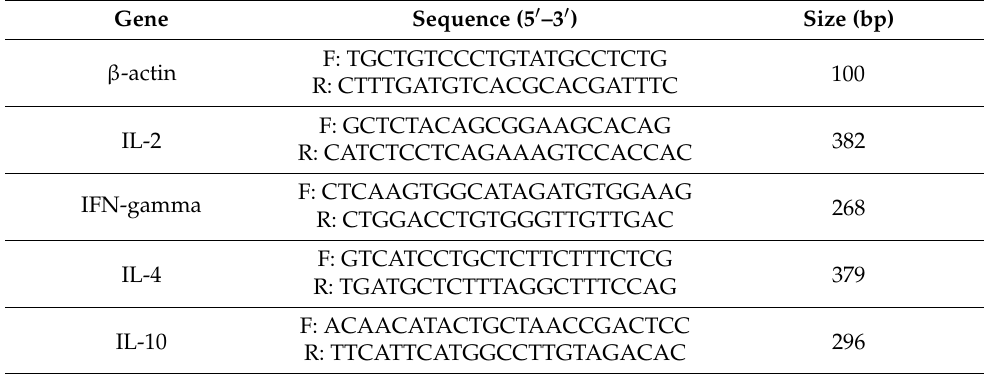
Table 2. Primers for qRT-PCR amplification used in this study.